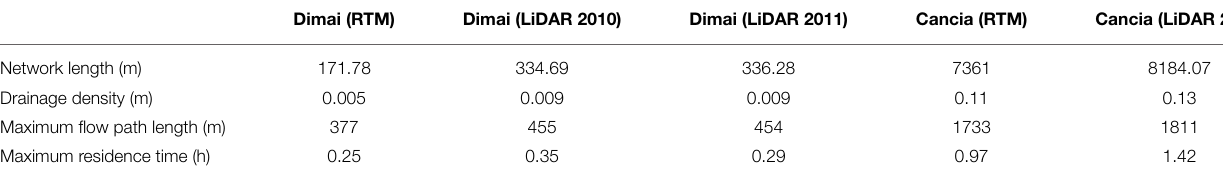
TABLE 4 | Morphometric characteristics obtained by the five different